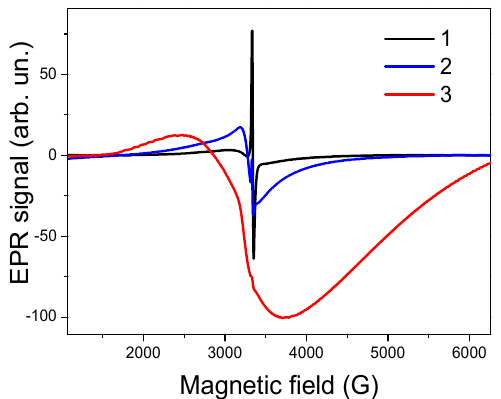
Figure 40. EPR spectra of Si NPs with different iron content increasing as 0.004, 0.02 and 0.2 at. % for curves 1, 2 and 3, correspondingly. (Reprinted from Reference [101] by permission from John Wiley and Sons © 2019).